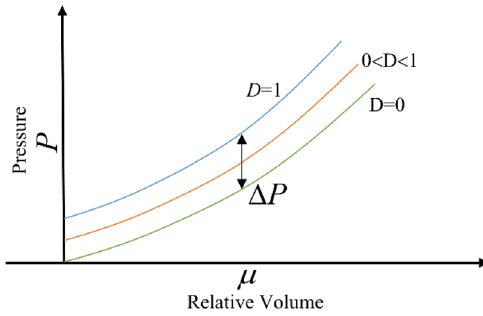
Figure 8. EOS model of the JH-2 constitutive